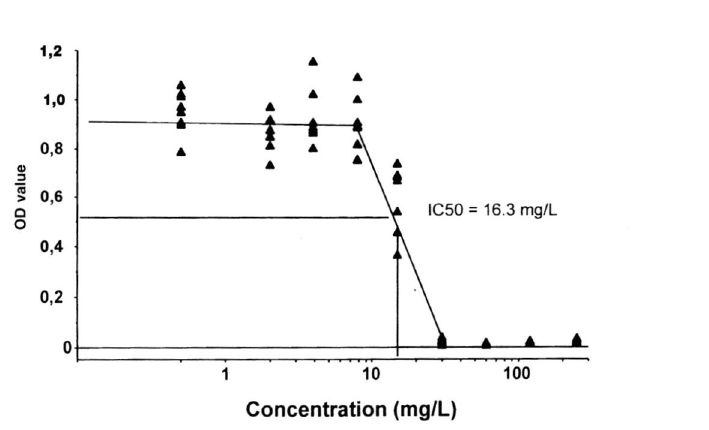
Fig. I. - In vitro effect of Vemonia colorata aqueous extracts (decoction) on T. gondii in MRC5 tissue culture. OD value for ELISA with infected monolayers versus concentrations of V. colo rata